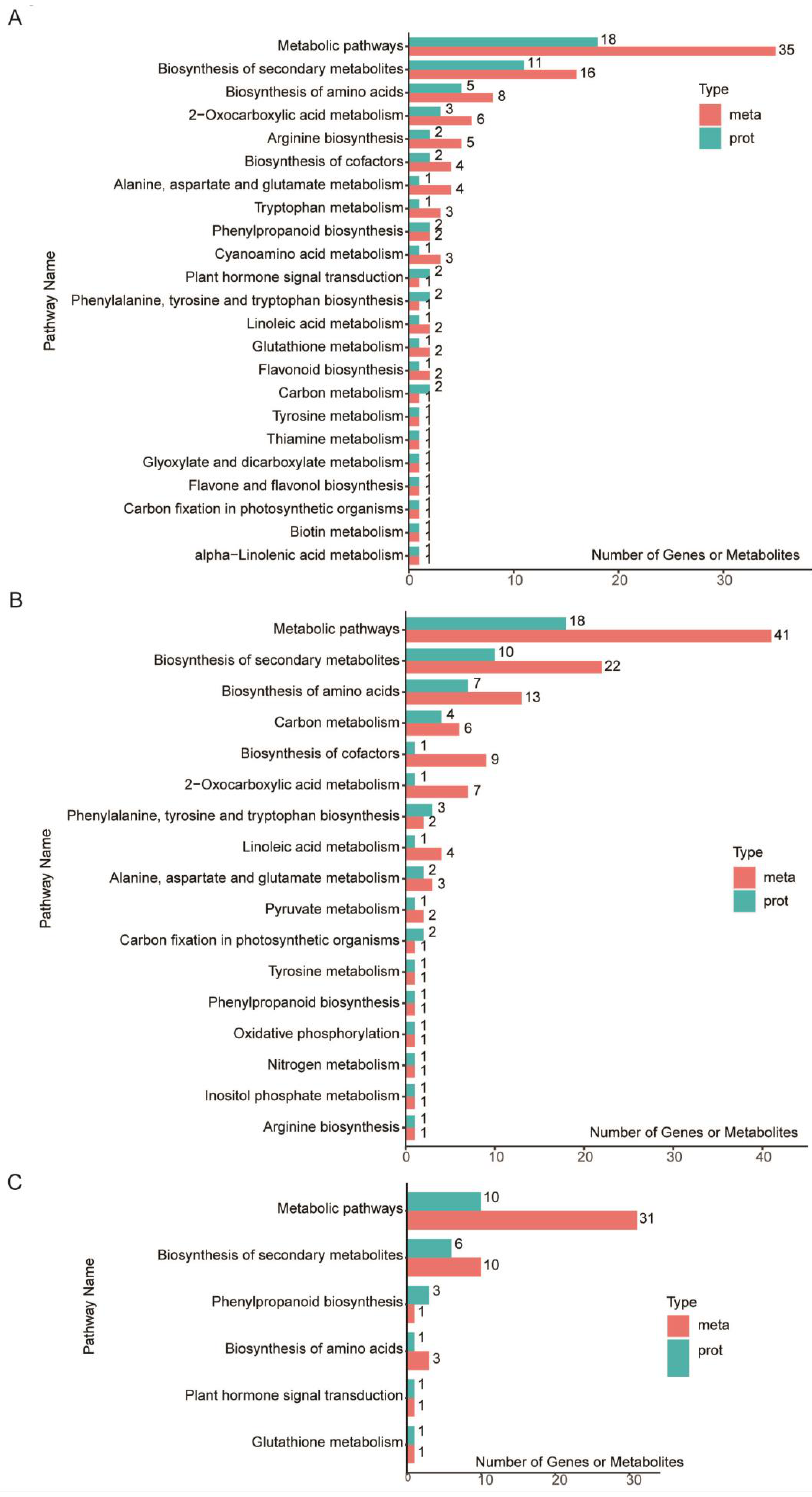
Figure 6. KEGG pathway enrichment analysis of the integrated DEPs and DAMs in BBL/ZH58 ( A ), BFL-1/ZH58 ( B ), and BFL-2/ZH58 × CH72 ( C